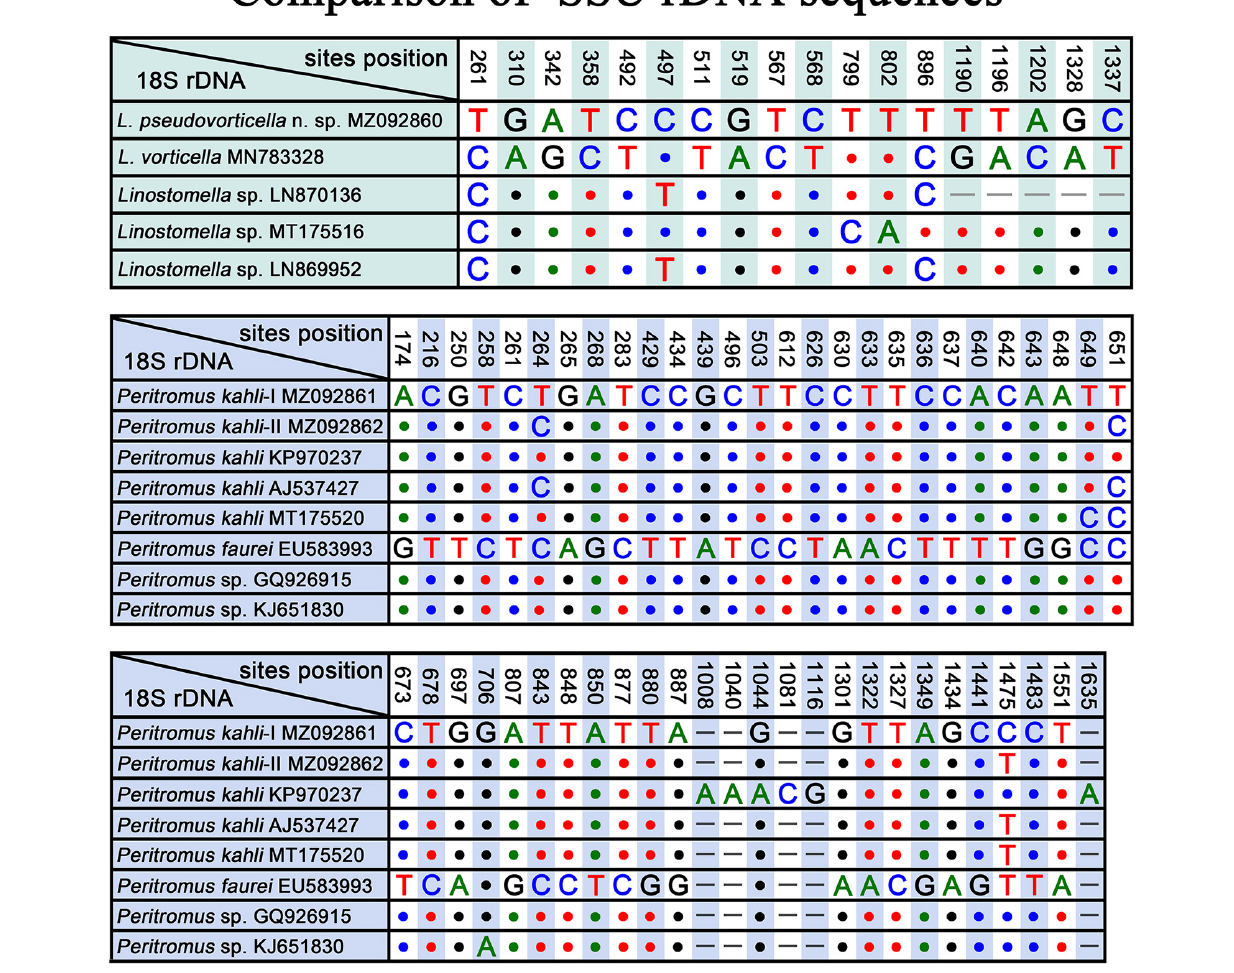
FIGURE 8 | SSU rDNA sequence comparisons showing the unmatched nucleotides between Linostomella pseudovorticella n. sp. and related species, and the unmatched nucleotides among Peritromus kahli , Peritromus faurei , and related species. Nucleotide positions are given at the top of each column. Insertions and deletions are compensated by introducing alignment gaps (–). Matched sites are represented by dots